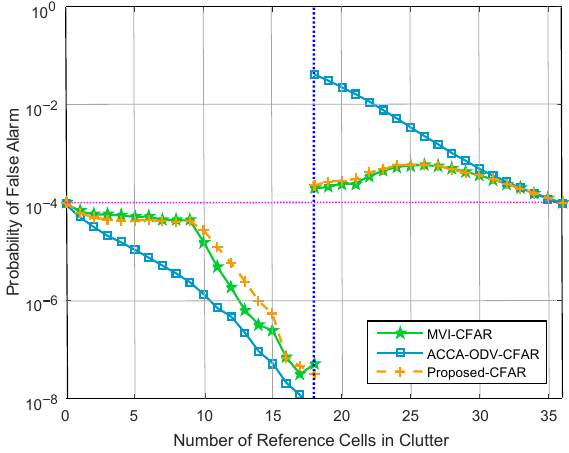
Figure 9. False alarm probability in clutter edge situation ( N = 36, P fa = 10 − 4 , and CNR = 10